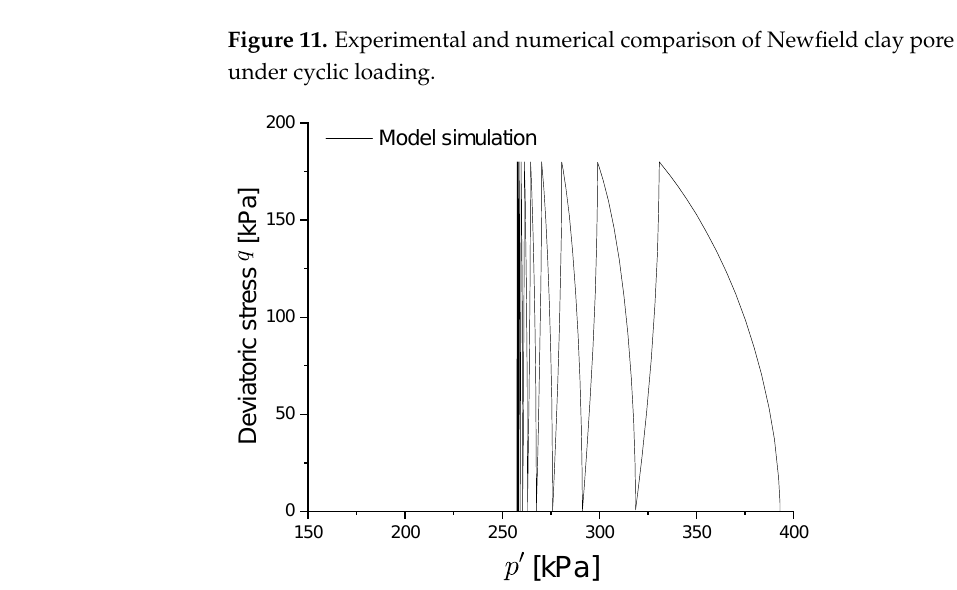
Figure 12. Predicted effective stress path under undrained cyclic